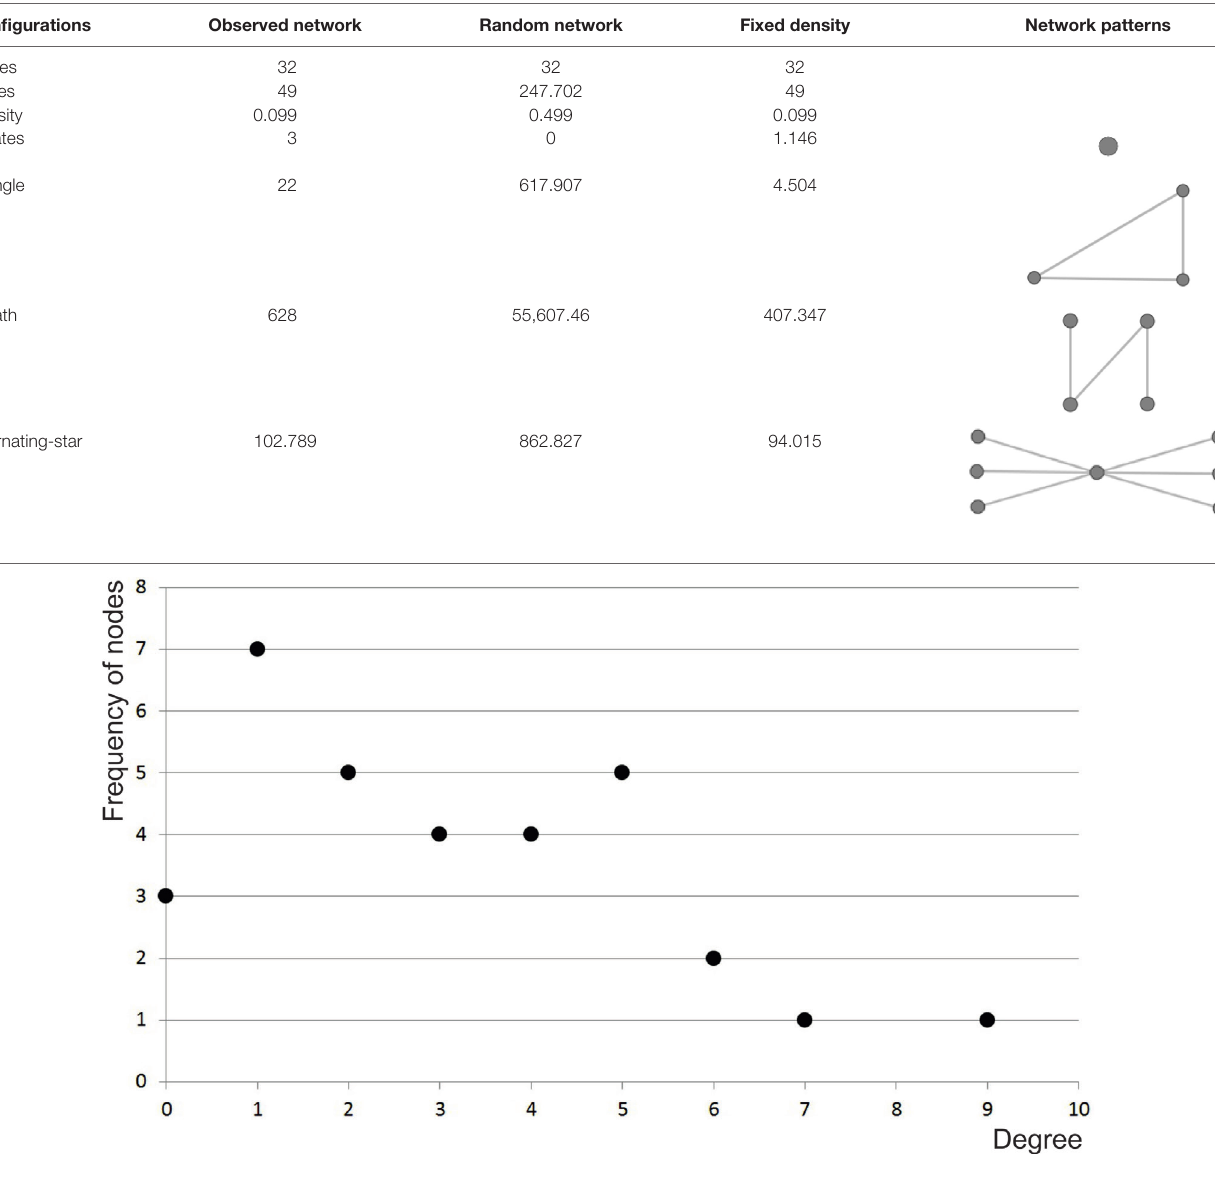
FigUre 12 | Degree distribution of subnetwork at the center of the Cranborne Chase study area shown in Figure 11 above.